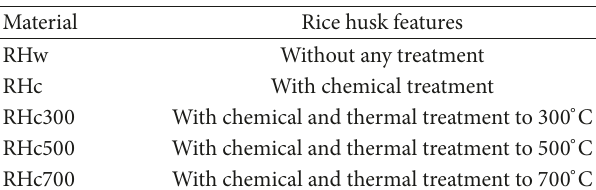
Table 2: Features of all prepared